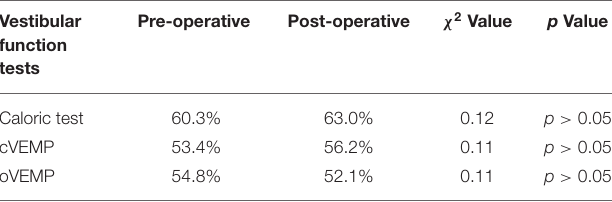
TABLE 2 | Abnormal rate of vestibular function tests pre- and post-operatively in resection of the lateral wall of endolymphatic sac group. Vestibular